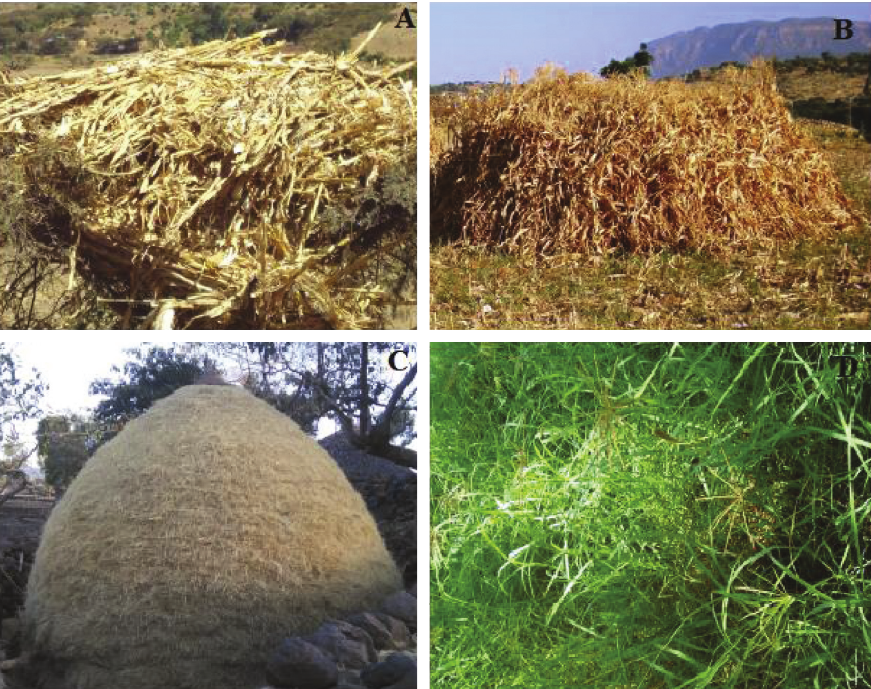
Figure 1: Some of the feeds available in the study area: (a) Sorghum stover, (b) maize stover, (c) Teff straw, and (d) green